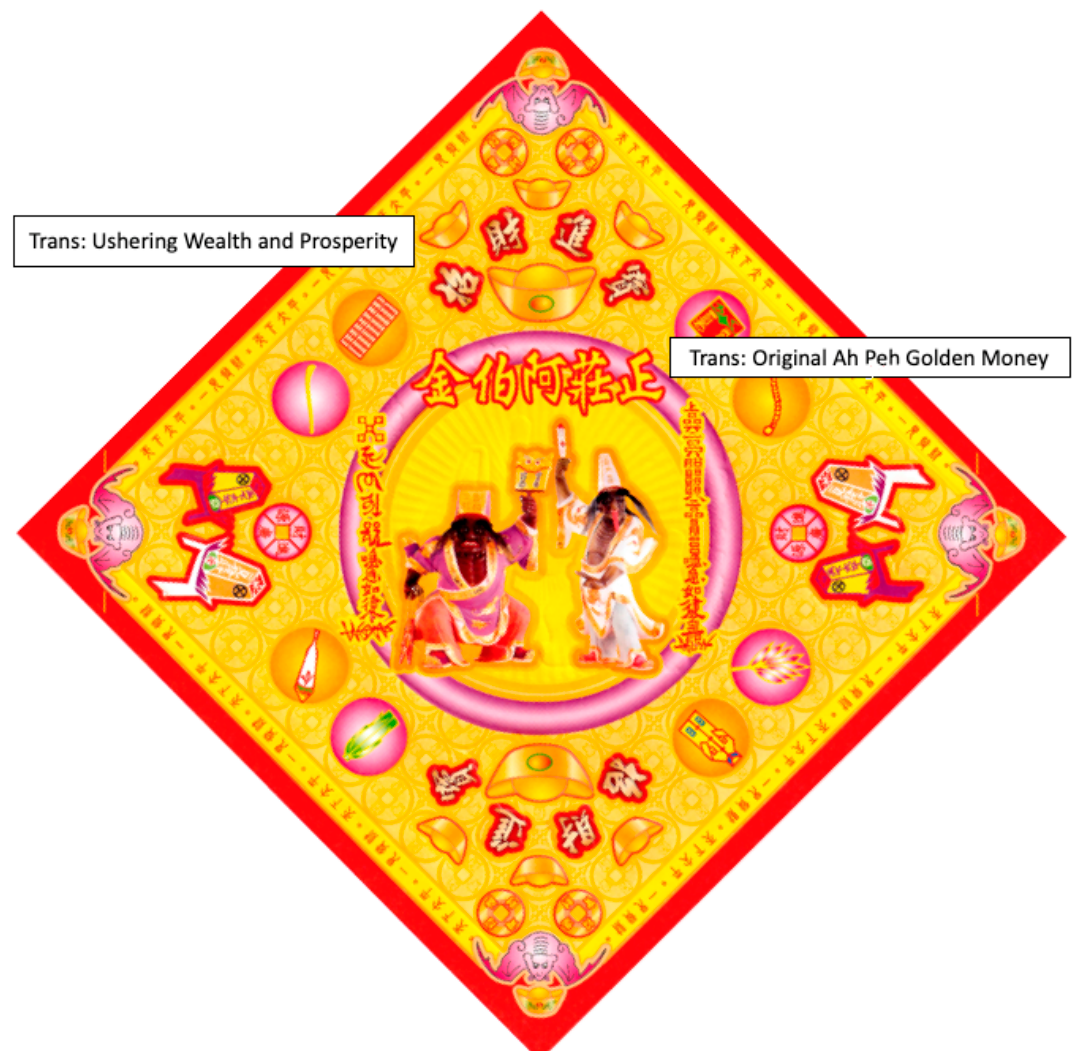
Figure 3. Modern paper money o ff ered to the Ah Pehs (Source: Author).